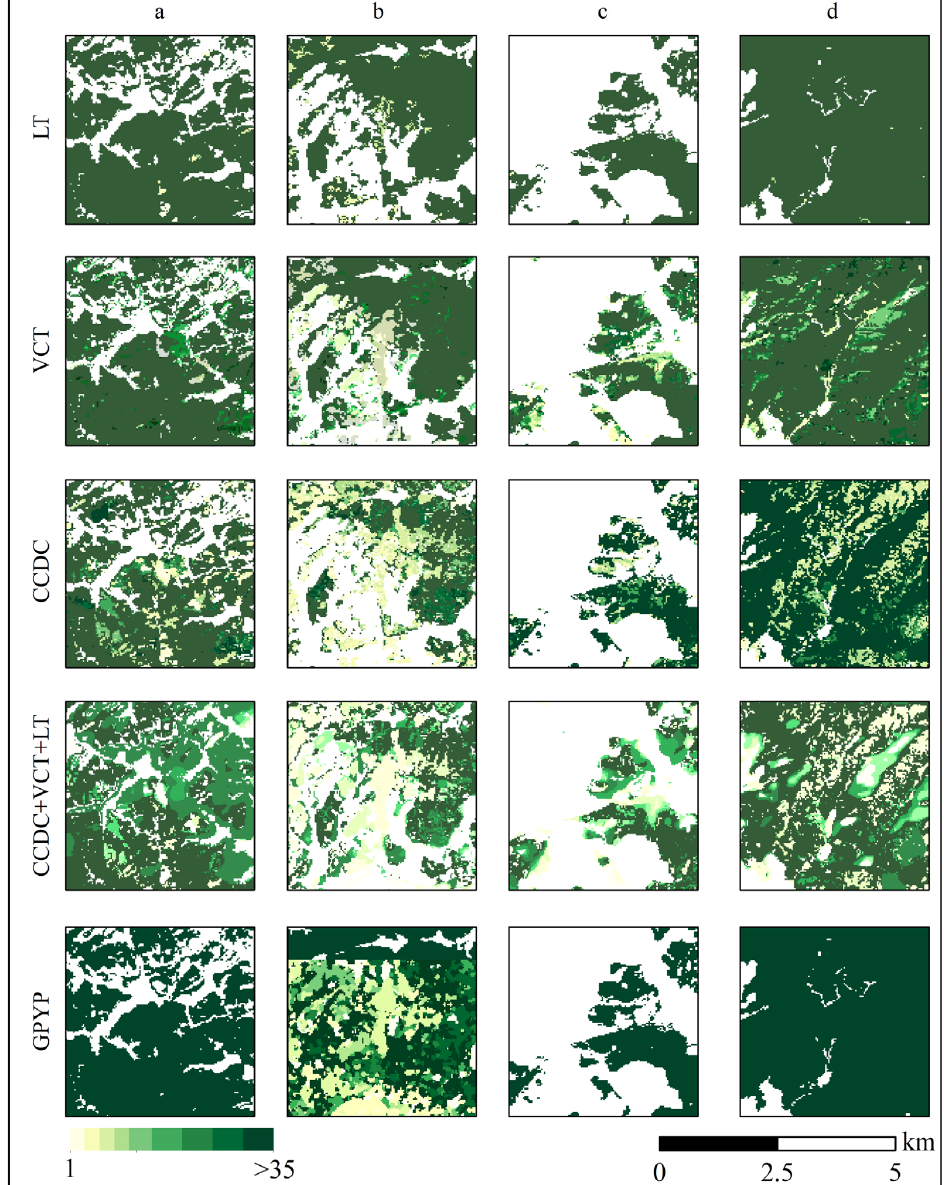
Figure 11. The comparison of the SFA maps produced by CCDC + VCT + LT; only LT, VCT, and CCDC; and GPYP in the four areas. From left to right in each column, ( a – d ) presents the four types of younger, middle-aged, premature forests, and mature forests in Figure 7.